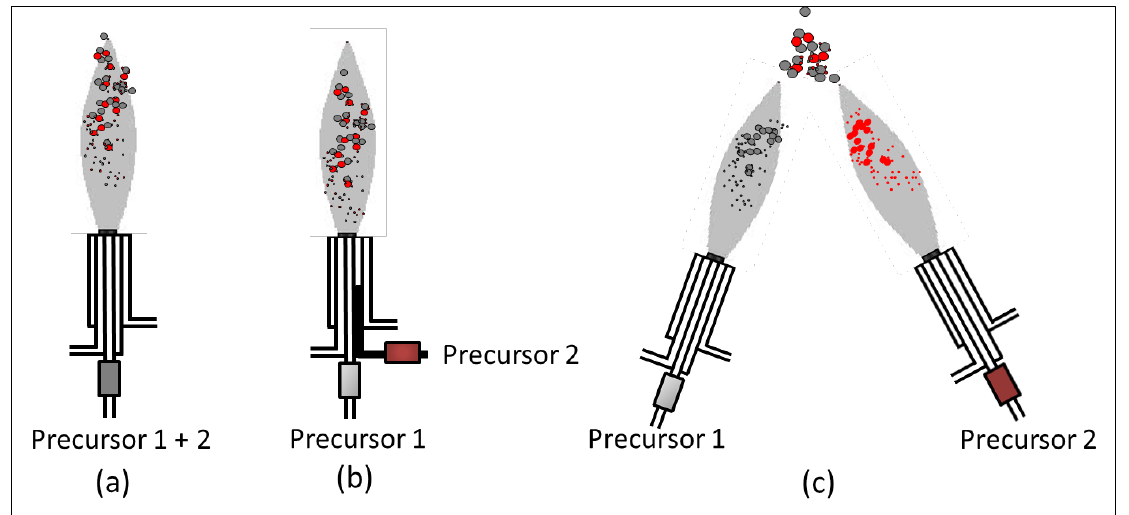
Figure 6. Feeding methods for the synthesis of composite materials by FS: ( a ) all precursors are mixed and fed together; ( b ) precursors are fed separately into different pots of the same nozzle (burner); ( c ) precursors are fed separately into different nozzles.